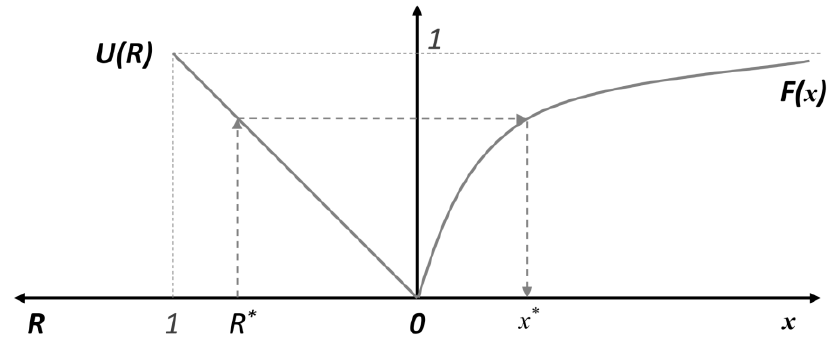
Figure 12. Conversion method to transfer random number to value of time at cumulative distribution.